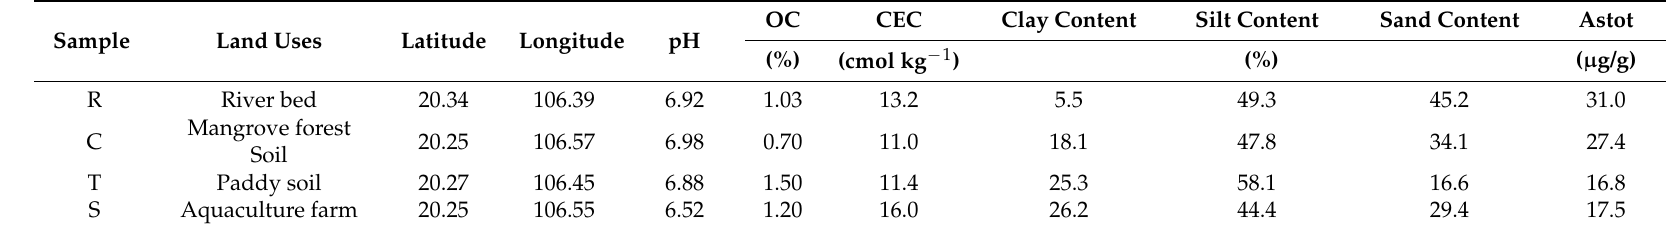
Table 2. The mean values of some major soil properties for four soil samples used in the